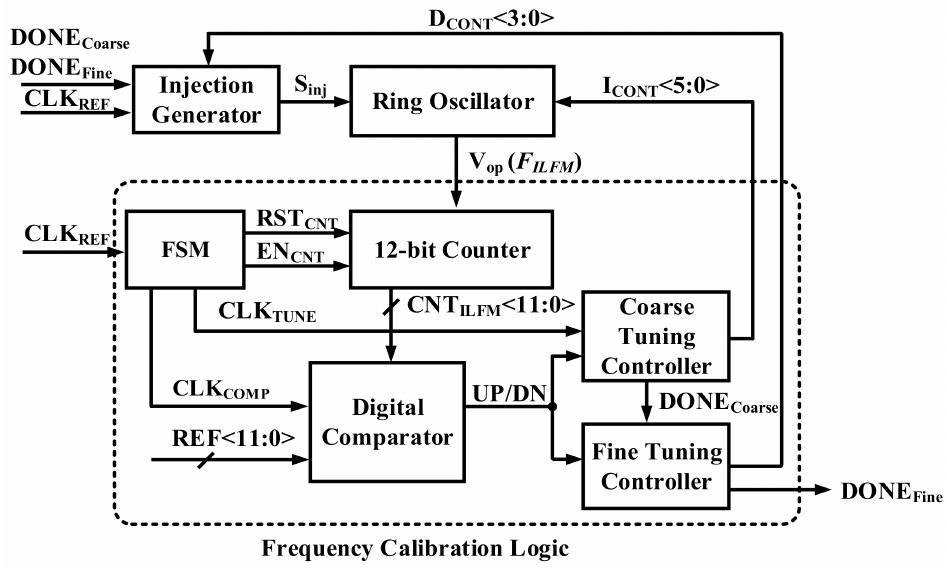
Figure 6. Block diagram of the Frequency Calibration